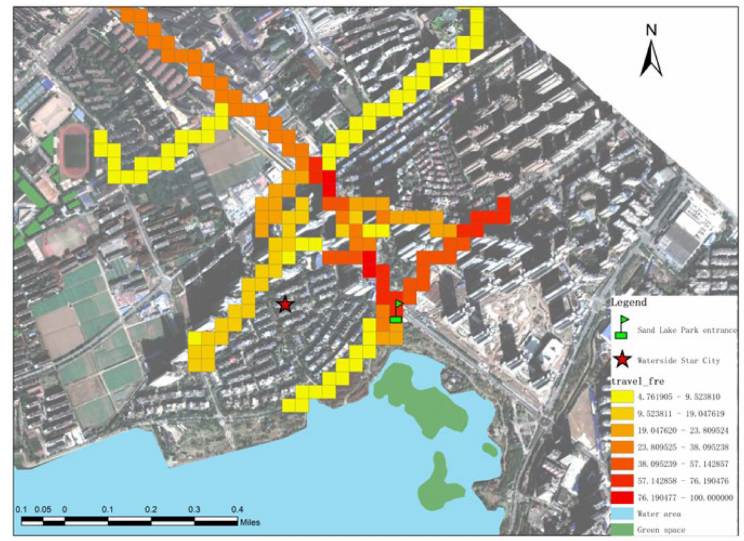
Figure 12. Spatially extended